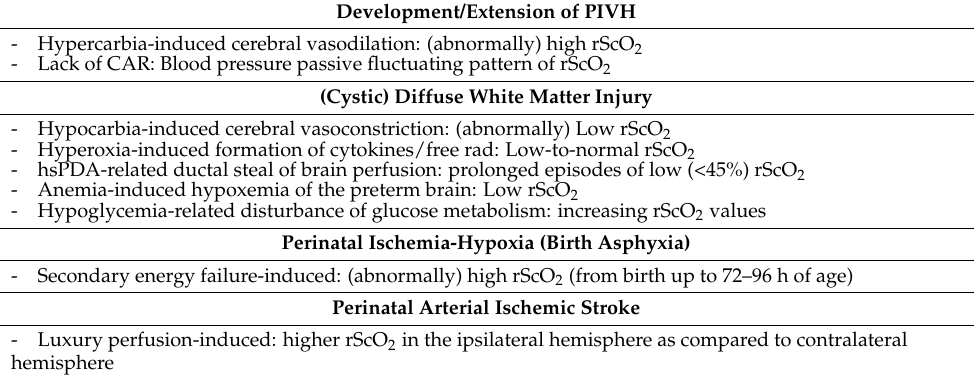
Table 1. Summary of associations between pathological substrate and pattern of cerebral